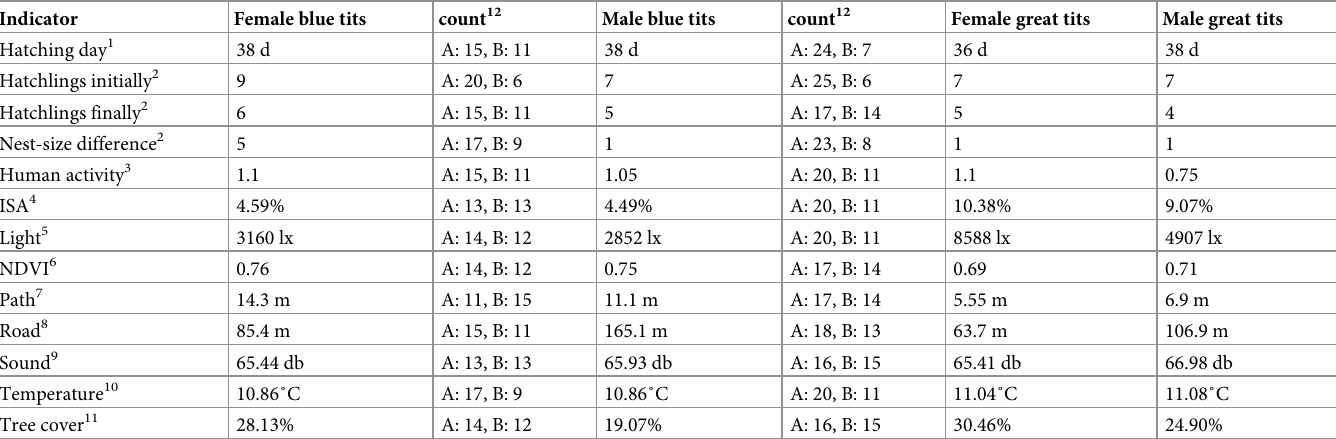
Table 1. Medians of the environmental data for each group of birds and counts of above/below median birds. Indicator